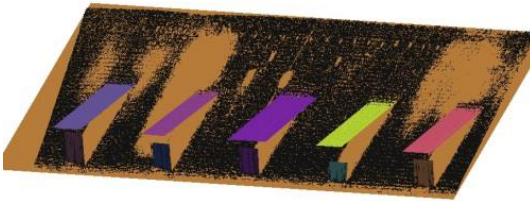
Figure 5. Grouping point clouds of dormers